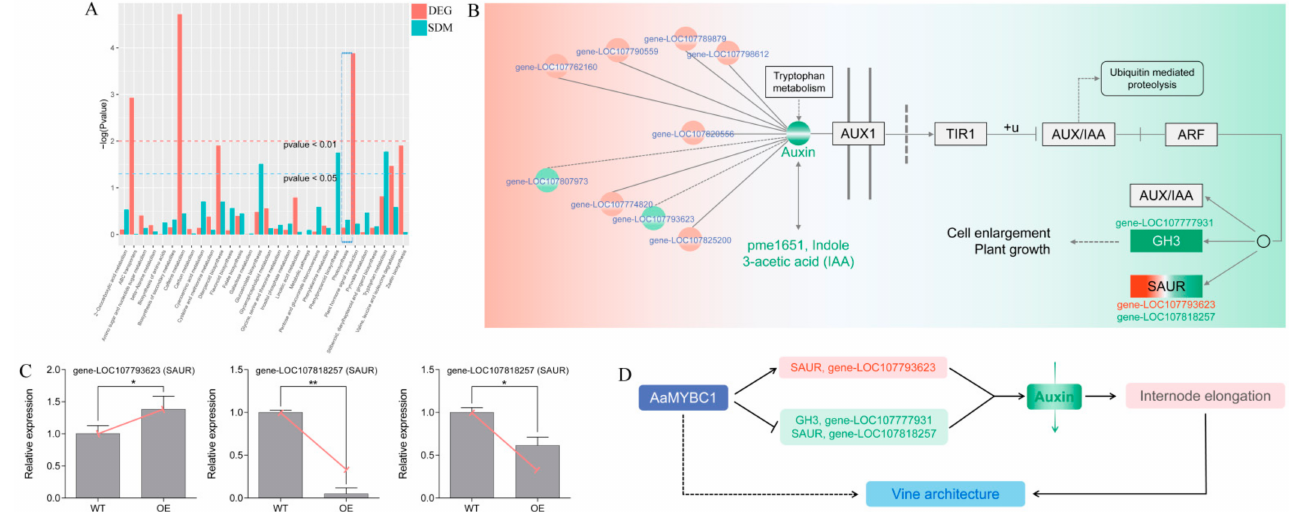
Figure 5. Regulatory mechanism of internode elongation based on combined analysis of metabolome and transcriptome. ( A ) Integrative KEGG pathway of DEGs and SDMs. The x -axis represents the metabolic pathway. The y -axis represents − log ( p -value) of DEGs indicated by red color bars and SDMs indicated by green color bars. ‘Plant hormone signal transduction’ is indicated by a blue dotted box. ( B ) Auxin signal transduction pathway including DEGs and SDMs. pme1651, annotated as IAA, was the unique auxin-related SDM detected in OE vs. WT comparison group. A total of nine DEGs